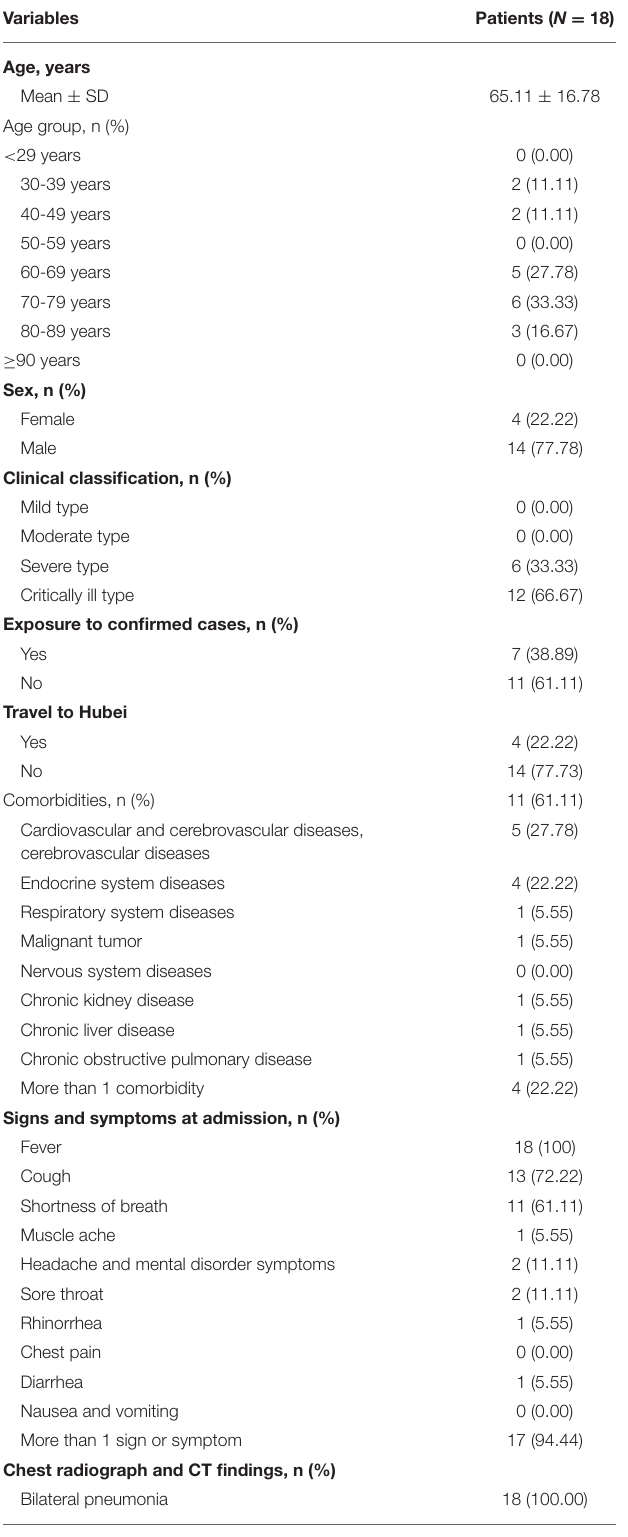
TABLE 2 | Demographic, baseline, and clinical characteristics of the 18 patients with COVID-19 in Henan Province.